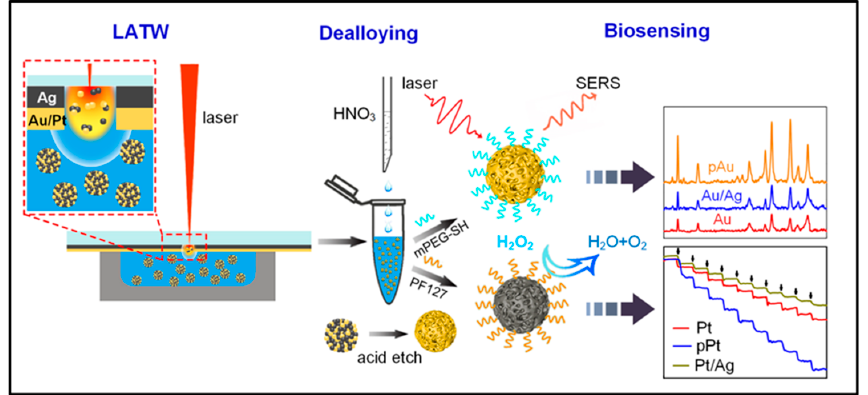
Figure 13. Schematic illustration of the fabrication process of pAu NPs and pPt NPs using LATW and dealloying for biosensing applications. Reprinted/adapted with permission from Ref. [79]. Copyright 2022, Elsevier.